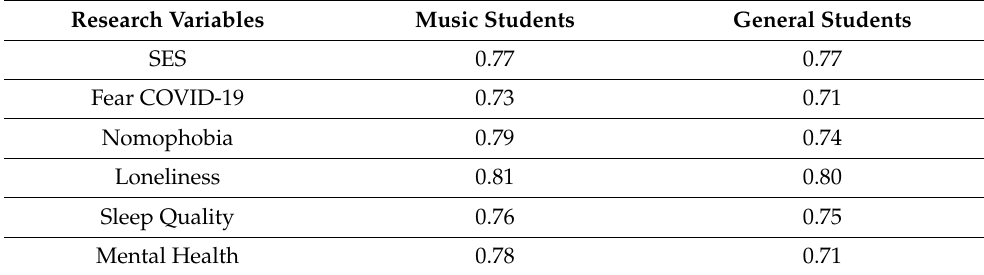
Table 2. Cronbach’s alpha